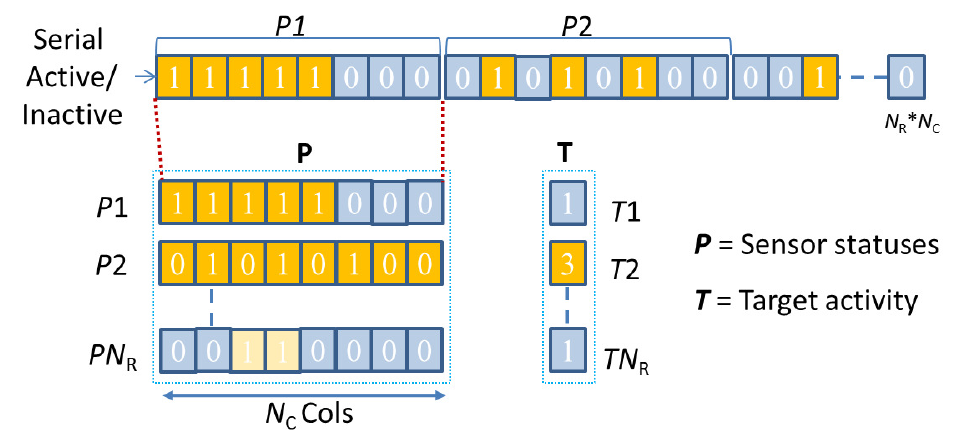
Figure 4. Pre-processing to convert serial photodiode sensor data into N R × N C predictor matrix, P and a N R × 1 target matrix, T. Absence of light is represented by logic-zero and sensed light is represented by logic-one. The target column vector contains the corresponding class or gesture